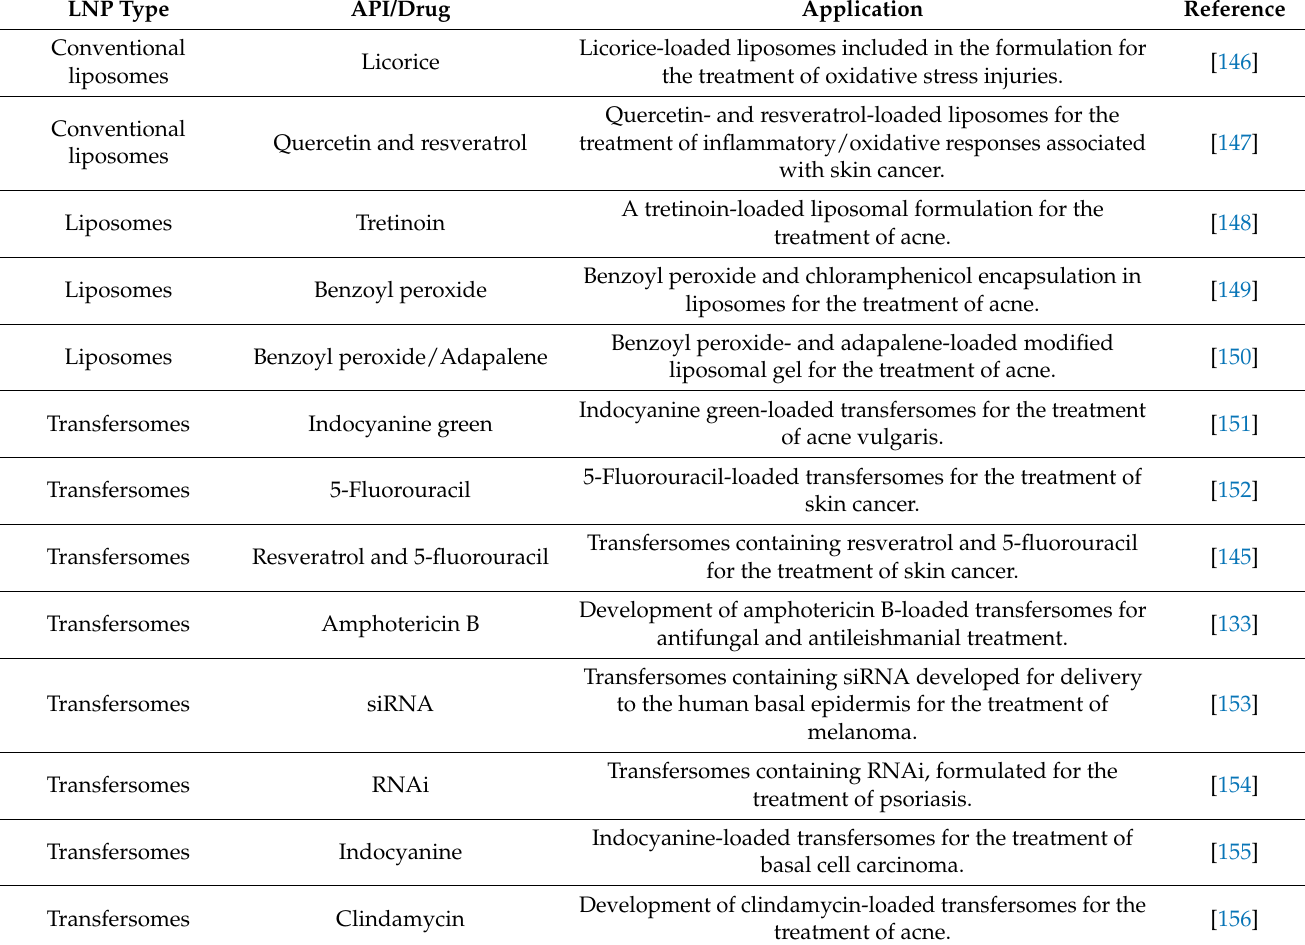
Table 5. Application of nanovesicular carriers in dermal DDS for the treatment of skin